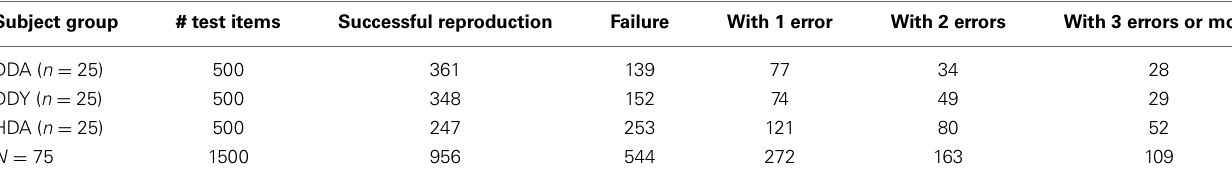
Table 2 | Distribution of errors across 1500